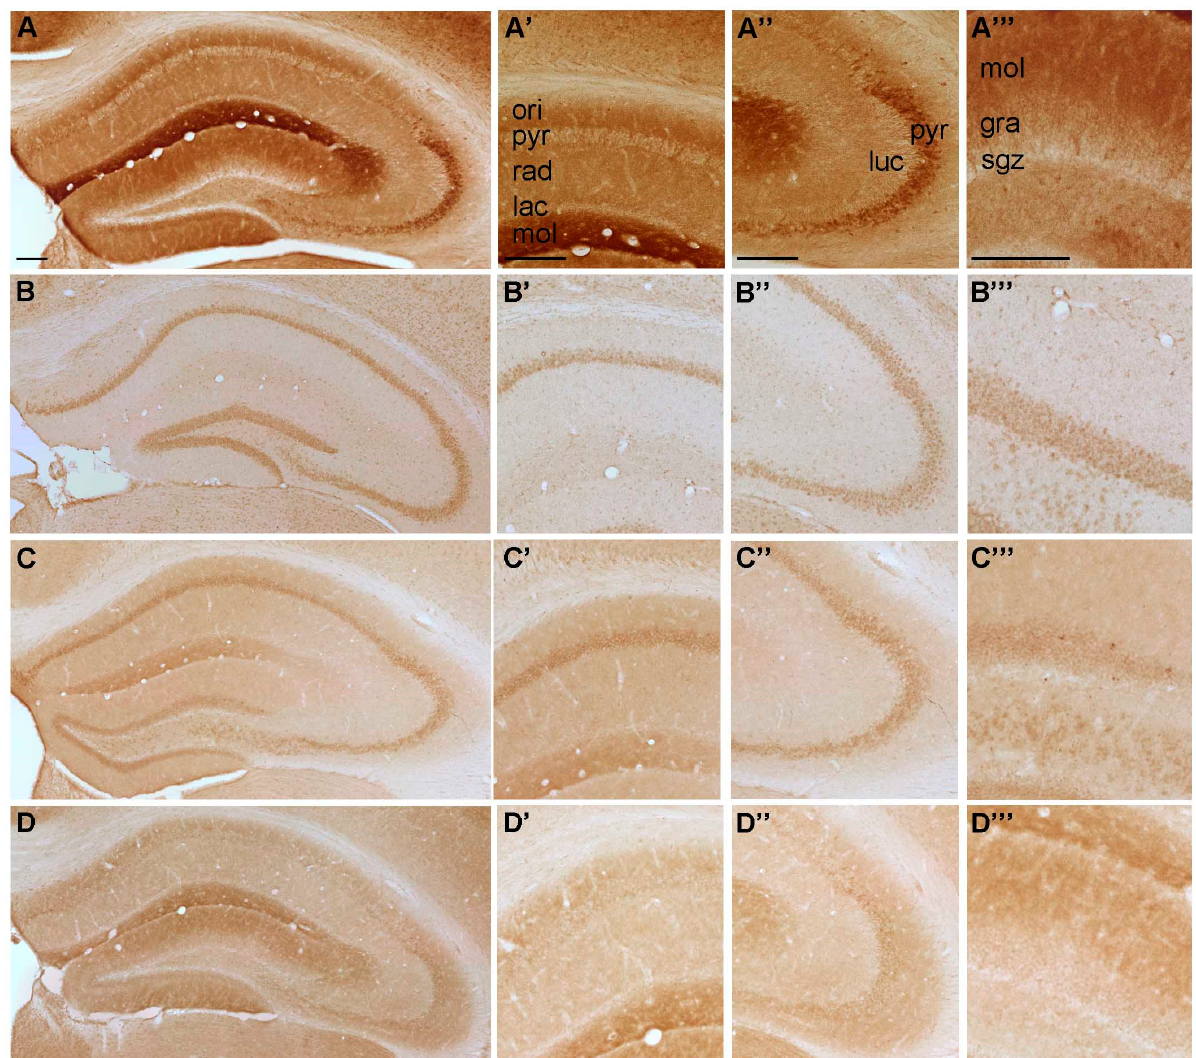
Figure 4. Representative microphotographs of ( A ) P2Y 11 -, ( B ) P2Y 12 -, ( C ) P2Y 13 and ( D ) P2Y 14 -IR in the mouse hippocampus. At higher magnification ( A’ ) P2Y11-IR in cornu ammonis (CA) 1, ( A” ) P2Y11-IR in cornu ammonis (CA) 3, ( A”’ ) P2Y11-IR in dentate gyrus, ( B’ ) P2Y12-IR in cornu ammonis (CA) 1, ( B” ) P2Y12-IR in cornu ammonis (CA) 3, ( B”’ ) P2Y12-IR in dentate gyrus, ( C’ ) P2Y13-IR in cornu ammonis (CA) 1, ( C” ) P2Y13-IR in cornu ammonis (CA) 3, ( C”’ ) P2Y13-IR in dentate gyrus, ( D’ ) P2Y14-IR in cornu ammonis (CA) 1, ( D” ) P2Y14-IR in cornu ammonis (CA) 3 and ( D”’ ) P2Y14-IR in dentate gyrus, respectively. Abbreviations: ori, stratum oriens, pyr, stratum pyramidale, rad, stratum radiatum; lac, stratum lacunosum; mol, stratum moleculare; luc, stratum lucidum; gra, stratum granulare, sgz, subgranular zone. Scale bars = 200 µm.